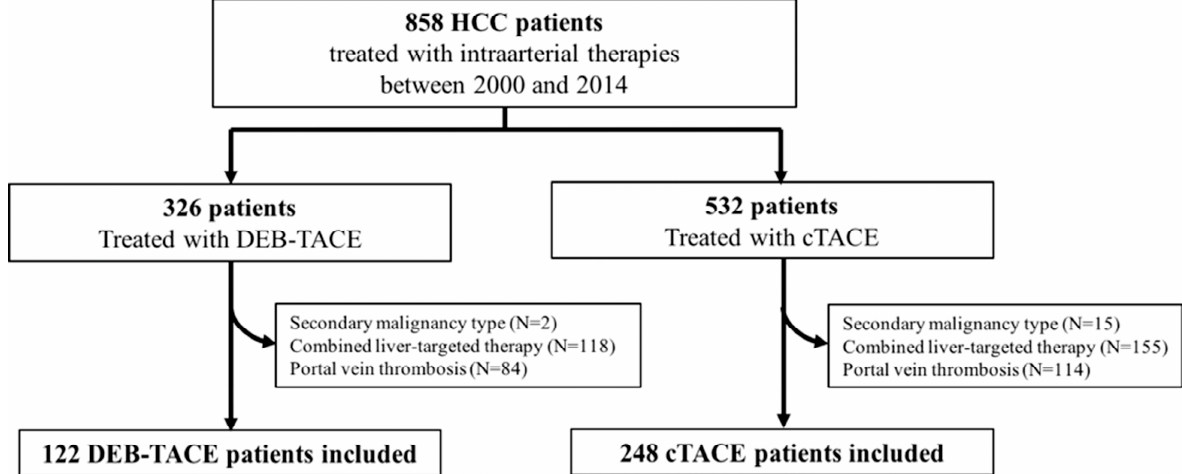
Figure 1. Flowchart of patient selection. HCC, hepatocellular carcinoma; cTACE, conventional transarterial chemoembolization; DEB-TACE, drug-eluting beads TACE; PVT, portal vein thrombosis.